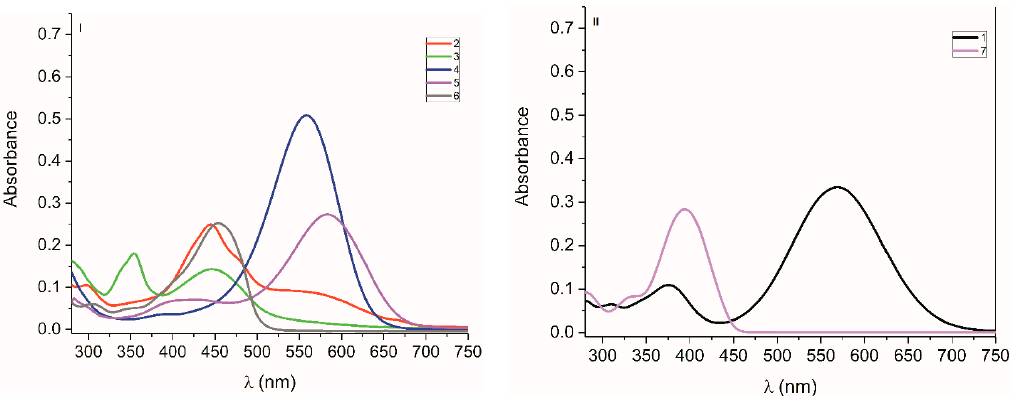
Figure 6. UV-Vis spectra of anions (1 × 10 − 5 mol · dm − 3 ) in the presence of TBAF (5 × 10 − 4 mol · dm − 3 ) in DMF: ( I ) (2) 2 E , (3) 2 Z , (4) 3 E (5) 3 Z , (6) 1 Z , ( II ) (1) 5 Z , (7) 4 Z .